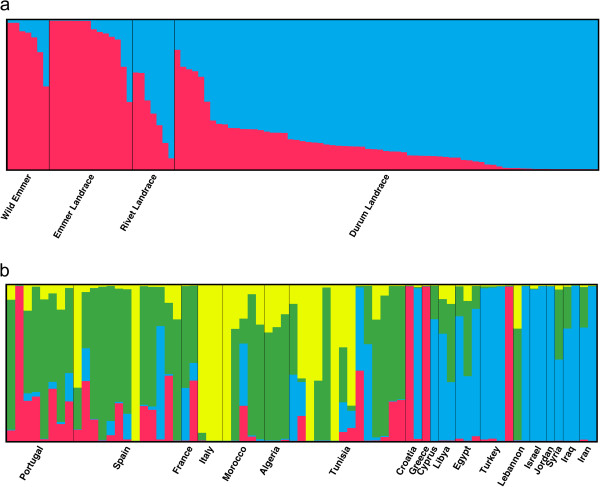
Results of Principal Component Analysis (PCA) of tetraploid wheat accessions based on 369 SNP markers. Each dot represents the location of a wheat accession along the first two principal components. Black = wild emmer; purple = landrace emmer; red = durum; orange = rivet.